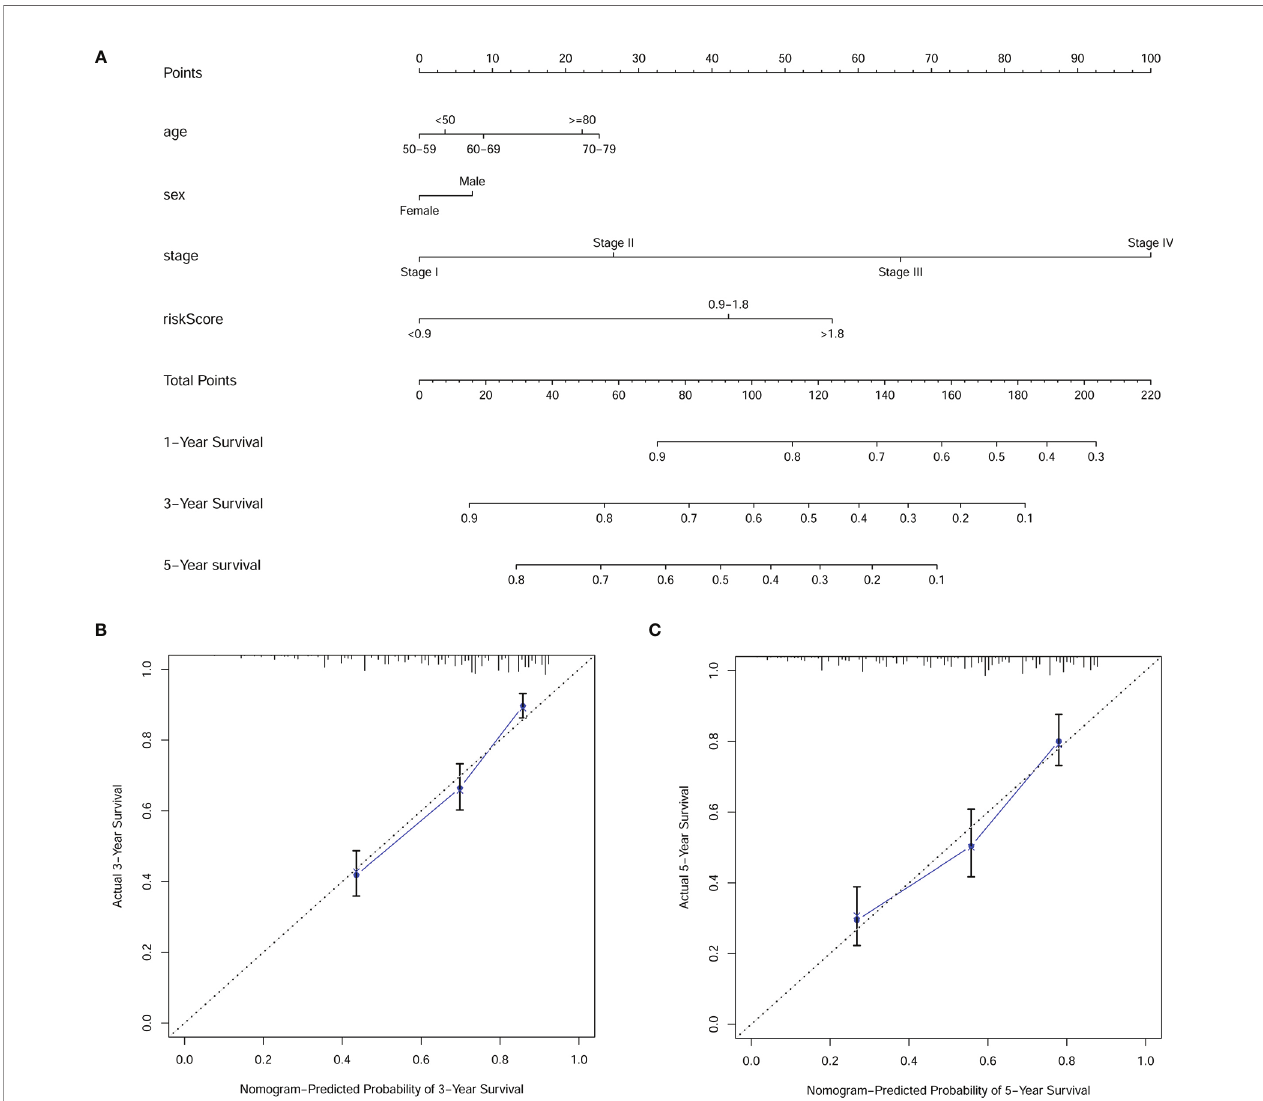
FIGURE 6 | The (A) nomogram and (B, C) calibration plots of 3 and 5 years demonstrated that the combination of risk score and clinicopathological characteristics could well predict the prognostic performance of patients with digestive system